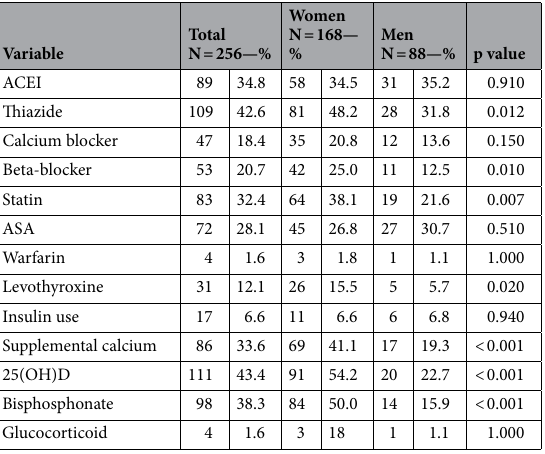
Table 3. Absolute and relative frequencies of medications used in 256 older adults, separated by sex. ACEI angiotensin-converting enzyme inhibitor, ASA acetylsalicylic acid, 25 ( OH ) D 25-hydroxyvitamin D.